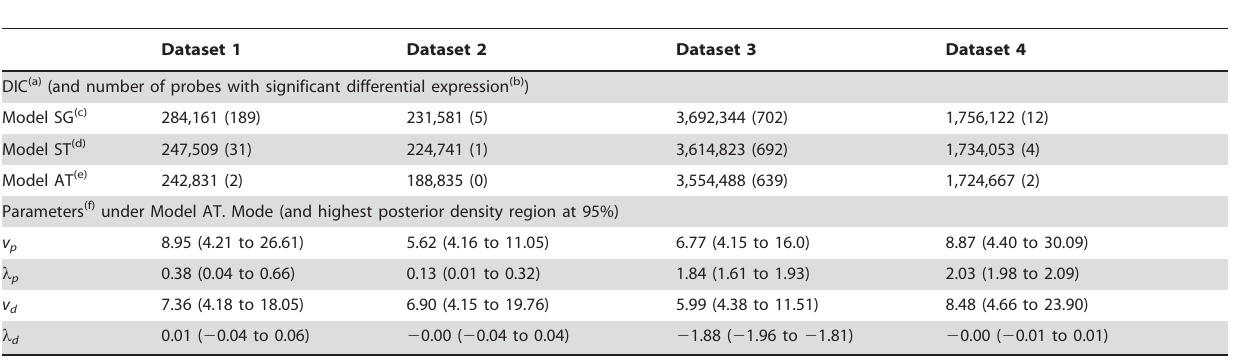
(a) Deviance information criterion. (b) Differentially expressed genes after Bonferroni [29]-like correction ( a =0.05). The adjusted significance threshold for posterior probabilities was calculated as a / p , were p was the number of probes included in each analysis. Random effects g and d ( g ) were assumed as symmetric Gaussian (c) , symmetric Student’s t (d) or asymmetric Student’s t (e) distributed following Sahu et al. [18]. (f) Degrees of freedom ( v ) and asymmetry parameter ( l ) for probe ( p ) and differential expression within probe ( d ) effects.